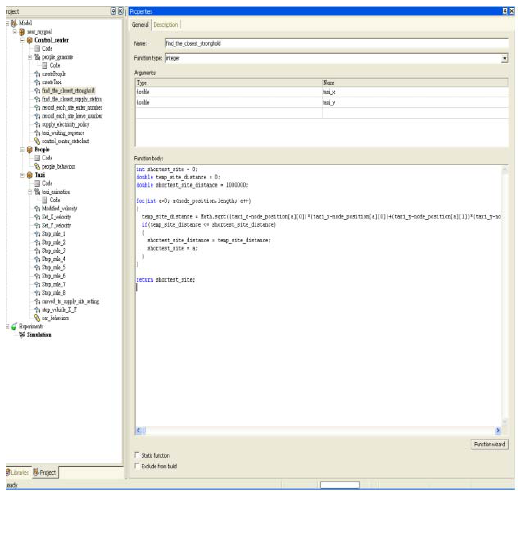
Figure 13(c). “The management policies of electric-taxi DAR operation system”.